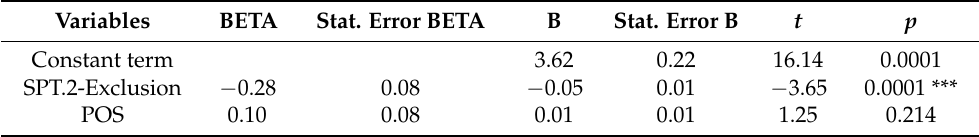
Table 11. Determinants of the ‘satisfaction with support received’ variable